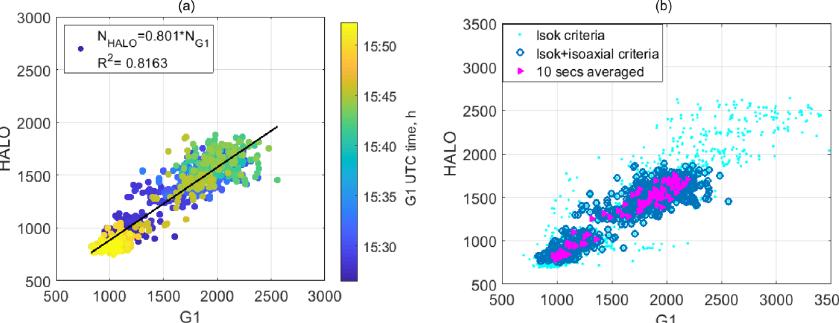
Figure 6. The G1 and HALO comparison for aerosol number concentration (cm − 3 ) measured by CPC (>10nm) on 9 September: (a) with isokinetic inlet constrain; (b) with different